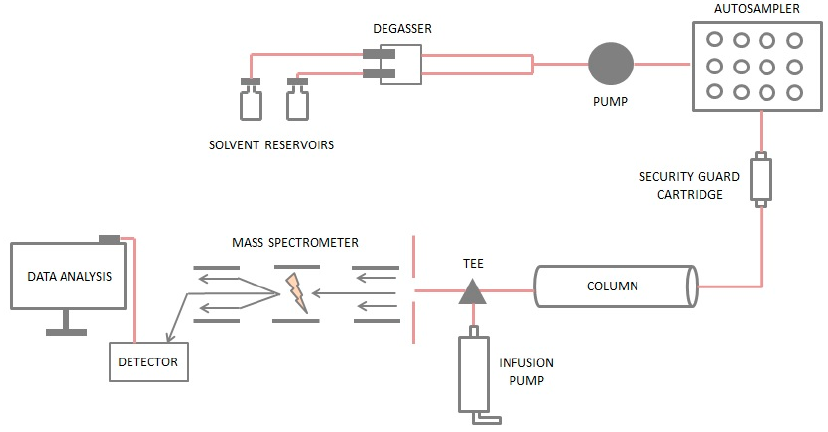
Figure 5. The schematic of the post-column infusion system for evaluation of matrix effects.